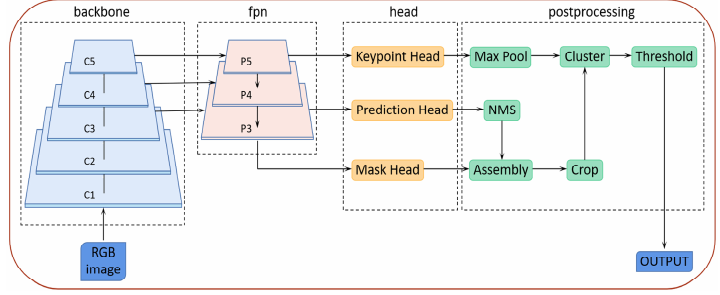
Figure 5. Key-Yolact architecture.